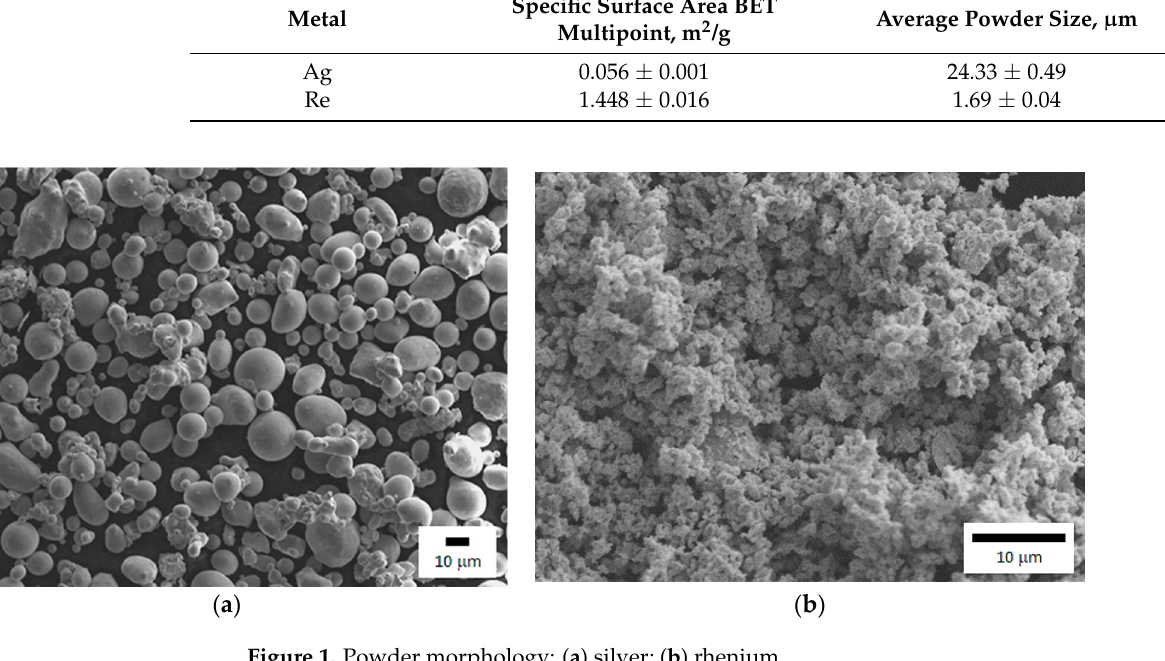
Table 2. Chemical composition of the